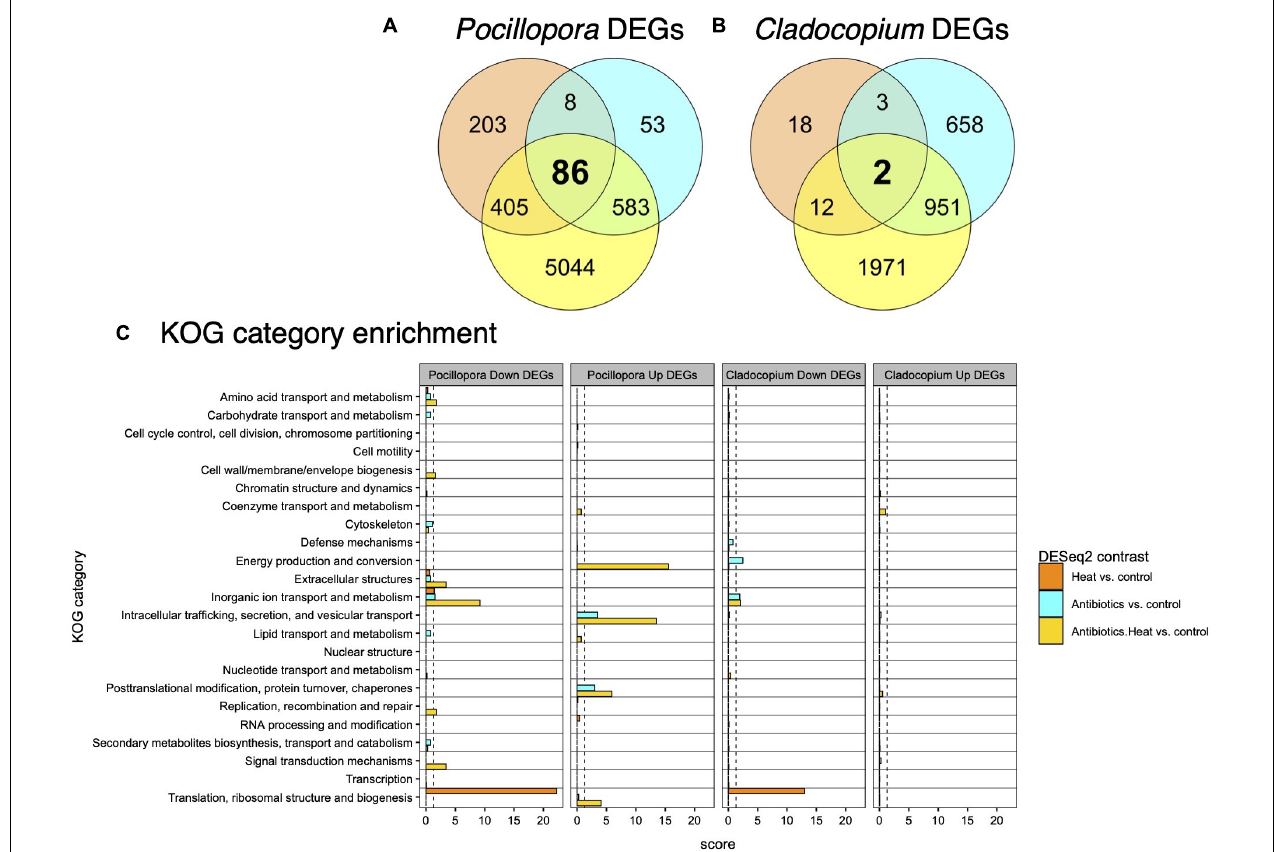
FIGURE 3 | The overall summary of shared and unique DEGs detected in Pocillopora and Cladocopium . Venn diagrams of the number of shared and unique DEGs detected among experimental treatments contrasted with the control treatment for (A) Pocillopora corals and (B) Cladocopium algal symbionts. Thousands more DEGs are detected in the antibiotics and heat combined treatment than the individual antibiotics or heat stress treatments for both coral host and algal symbiont. (C) Barplots of enriched KOG categories for Pocillopora and Cladocopium upregulated and downregulated DEGs reveals that heat stress, antibiotics, and combined treatments affect different functional classes of genes. KOG categories are shown on the y -axis, and the x -axis depicts the enrichment score [–log10( p adj )] for each KOG category within each set of upregulated or downregulated